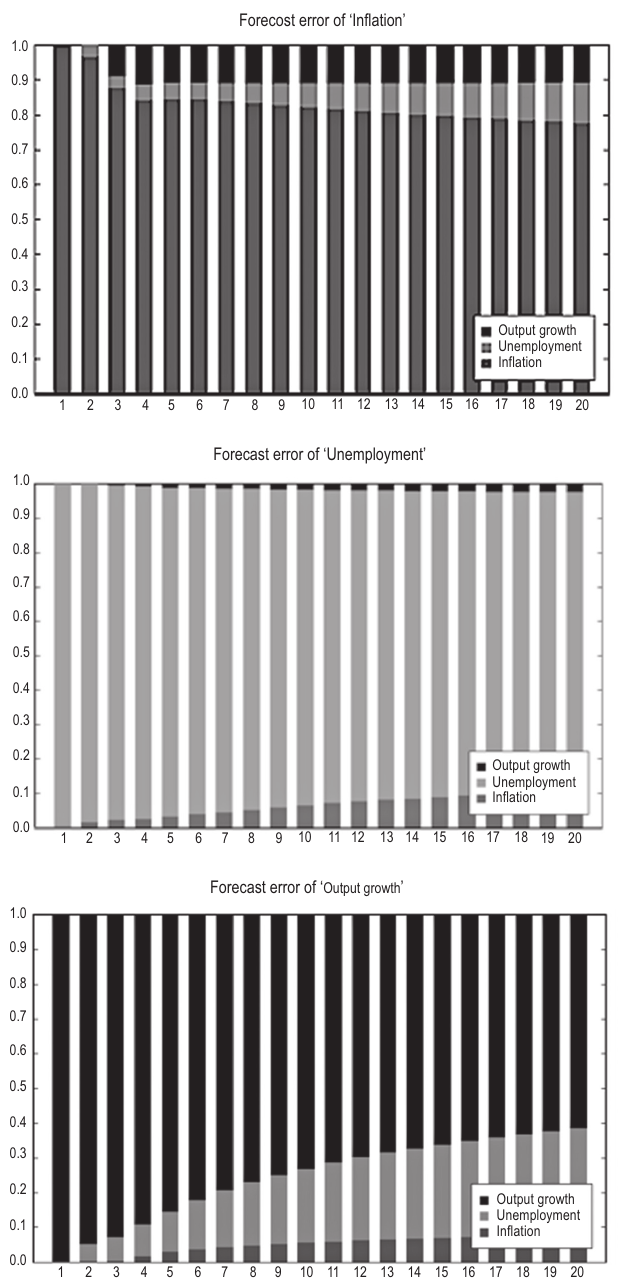
Fig. 3. Forecast error variance decomposition of inflation/unemployment/output Source: author